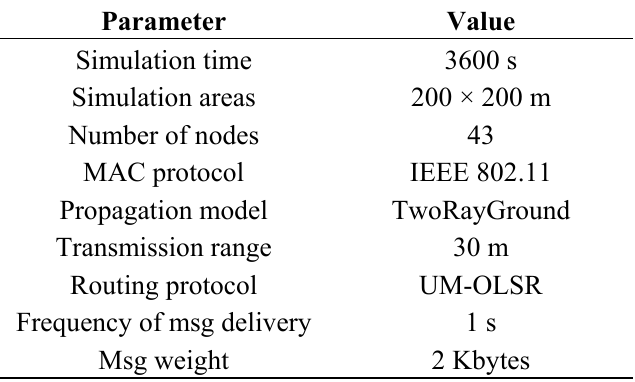
Table 1. Simulation parameters.